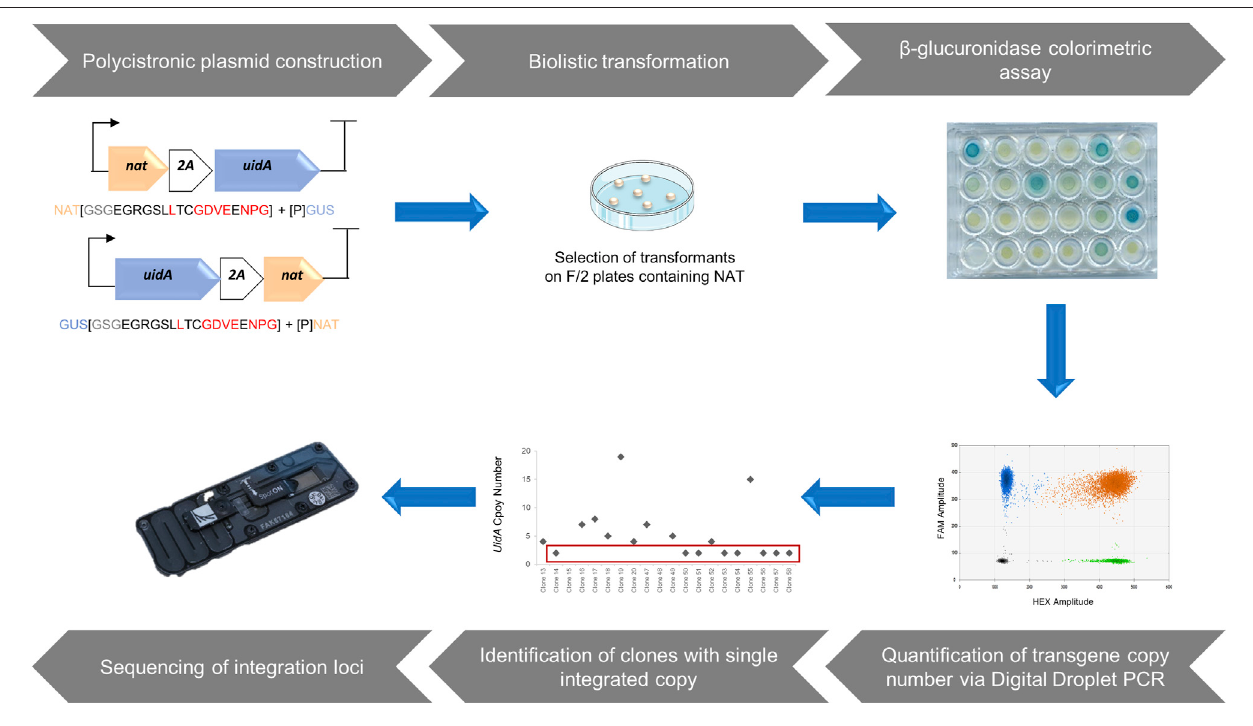
FIGURE 1 | A Step-by-step approach to identify loci enabling a high-level of heterologous gene expression. The design of polycistronic expression vectors using modularcloningsystemadaptedfromWeberetal.(2011).Polycistronicconstructionsweredeliveredintothe P.tricornutum genomethroughbiolistictransformationand the selection of transformants was based on antibiotic resistance. Phenotypic characterization of clones from the transformation was performed via β -glucuronidase colorimetric assay based on Falciatore et al. (1999). Assessment of the copy number of integrated transgenes was measured by a rapid, sensitive, and